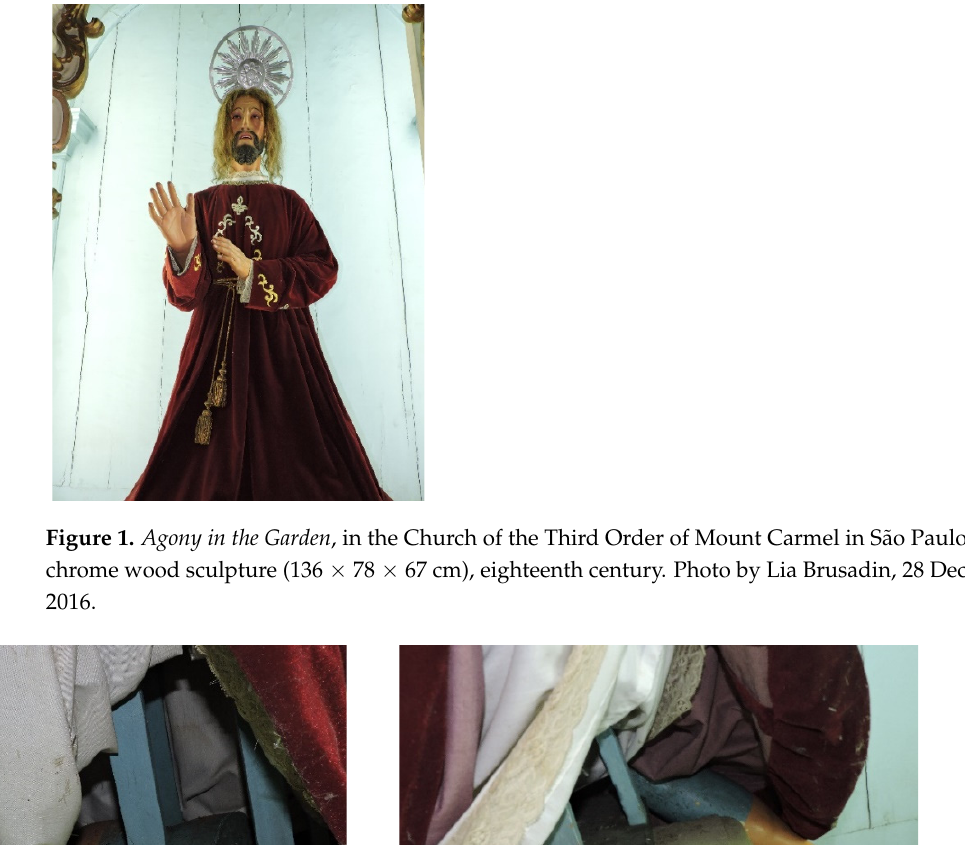
Figure 2. ( a ) Detail of the loose block of the right leg inside the slats. ( b ) Block of the left leg. Photos by Lia Brusadin, 28 December 2016.